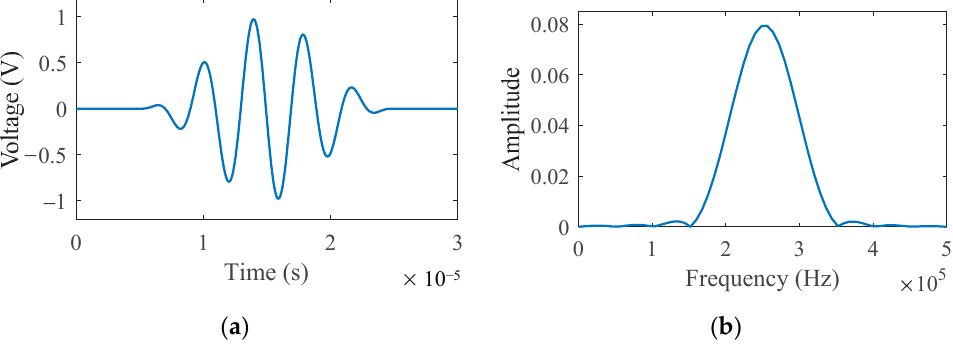
Figure 5. The excitation signals in ( a ) time domain; and ( b ) frequency domain.